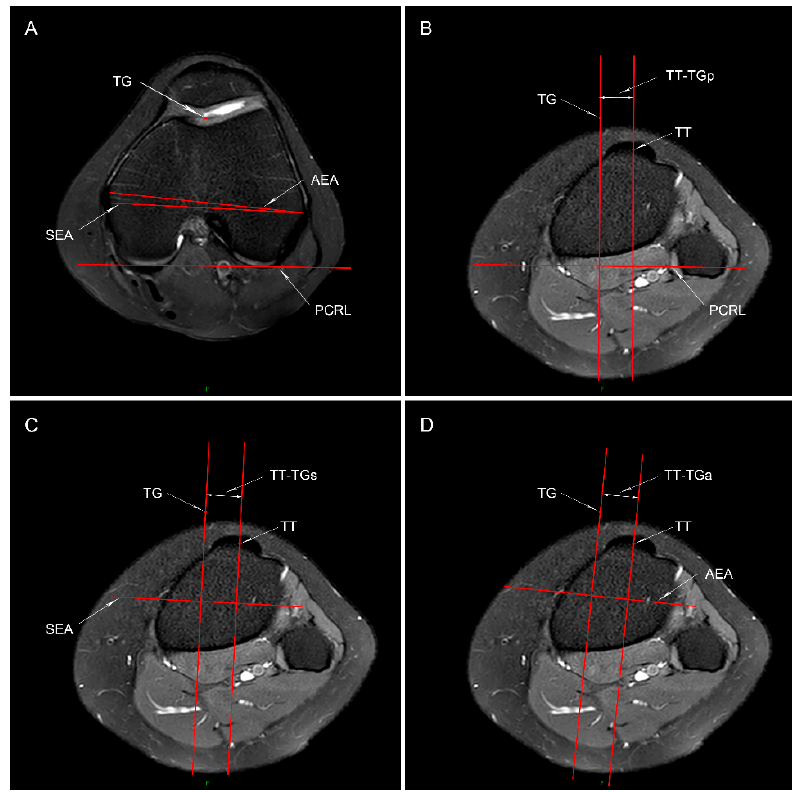
Figure 1. Measuring method of the tibial tubercle-trochlear groove (TT-TG) distance. ( A ) The posterior femoral condylar reference line (PCRL), surgical and anatomical transepicondylar axis (SEA and AEA, respectively), and the deepest portion of the cartilaginous trochlear groove (TG) are shown in the axial MRI plane. ( B – D ) The same slice showing the full attachment of the patellar tendon to the tibial tubercle is identified to mark the midpoint of the superficial aspect of tibial tubercle (TT). The TT-TGp ( B ), TT-TGs ( C ), and TT-TGa ( D ) distance is defined as the distance between two lines that are perpendicular to the PCRL, SEA, and AEA, respectively: one through the TG, and the other one through the TT.